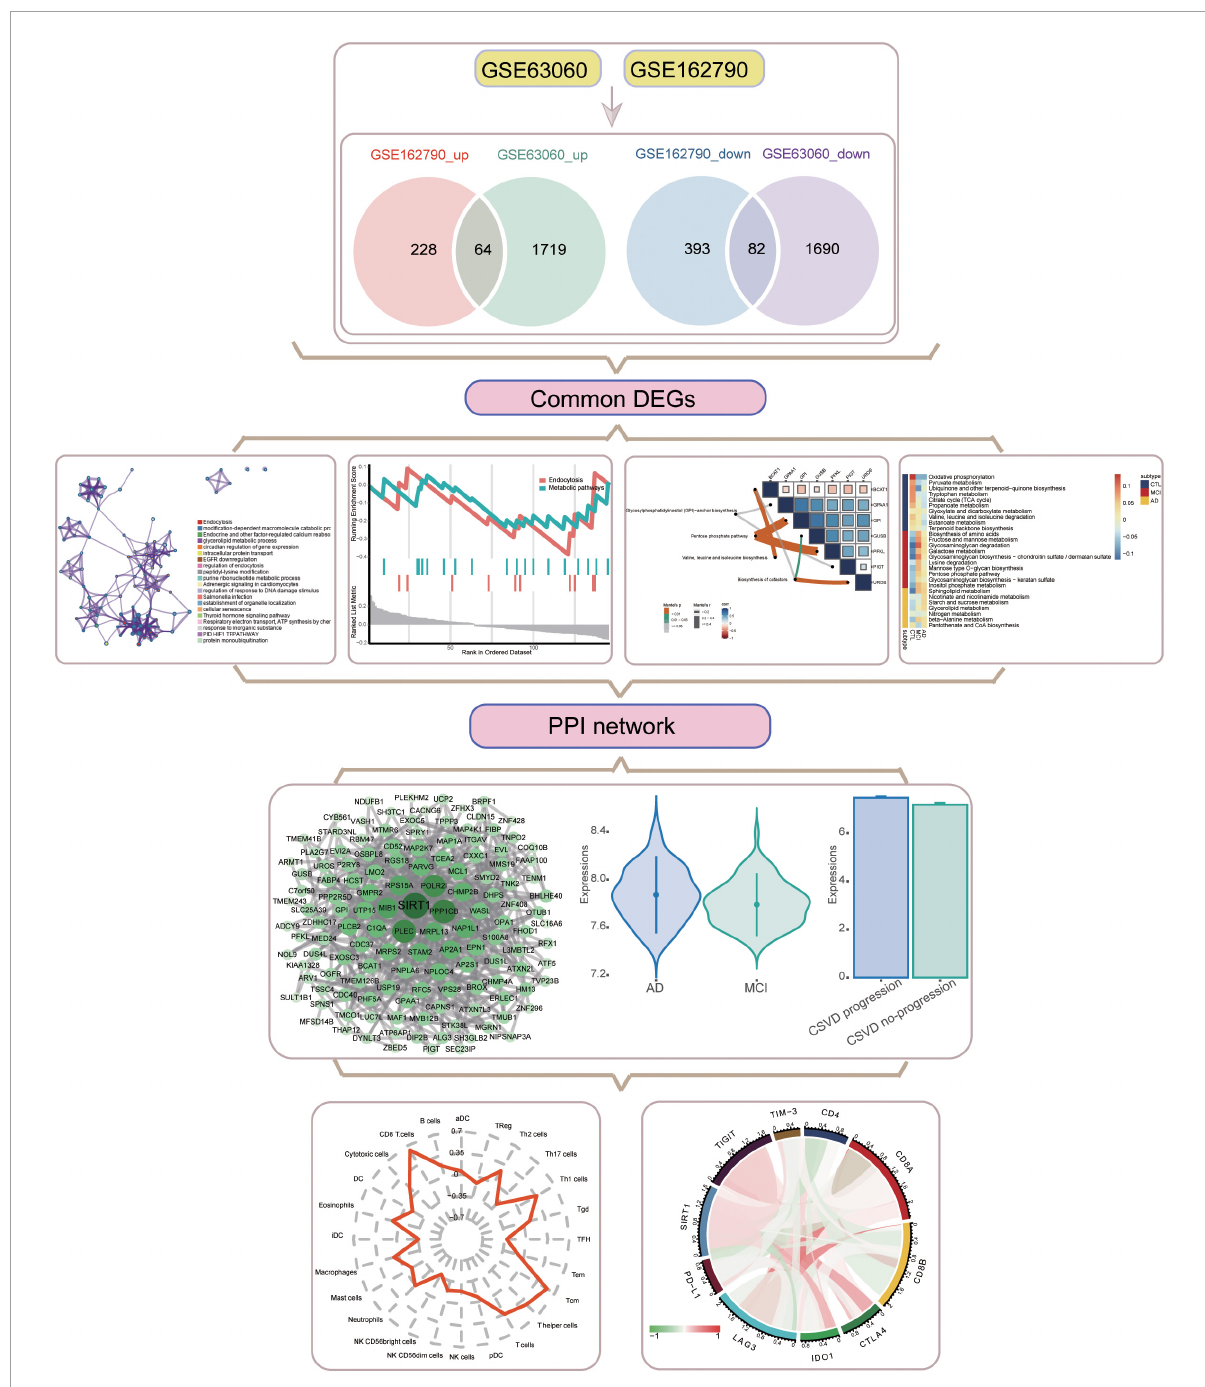
FIGURE1 Flowchart of this study. AD, Alzheimer’s disease; CSVD, cerebral small vessel disease. DEGs, differentially expressed genes; MCI, mild cognitive impairment; PPI, protein-protein